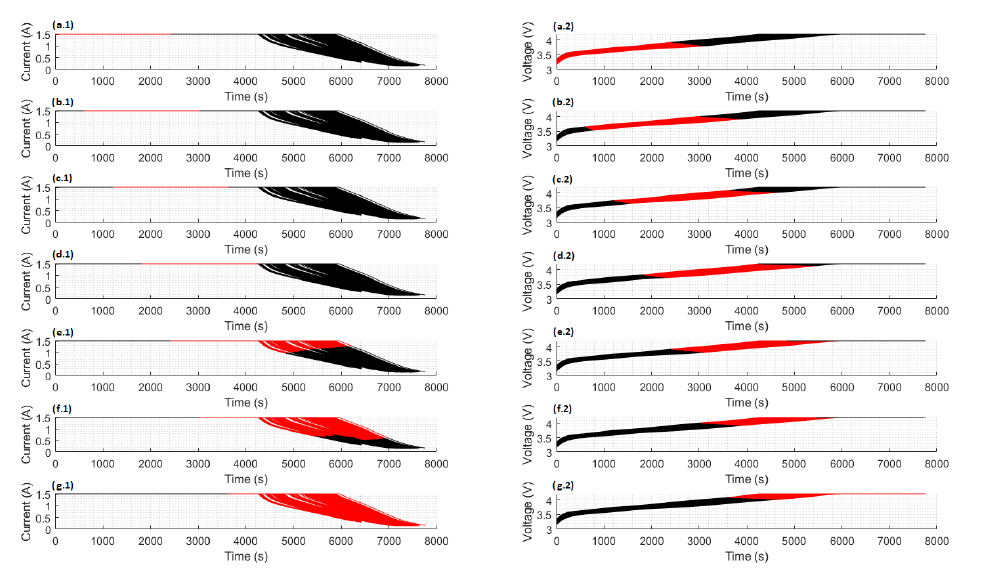
Figure 6. Fixed SOC window equal to 40% moving over the entire domain, for the generation of datasets. ( a.1 , a.2 ) are, respectively, current and voltage of SOC window [0,40]. ( b.1 , b.2 ) are, respectively, current and voltage of SOC window [10,50]. ( c.1 , c.2 ) are, respectively, current and voltage of SOC window [20,60]. ( d.1 , d.2 ) are, respectively, current and voltage of SOC window [30,70]. ( e.1 , e.2 ) are, respectively, current and voltage of SOC window [40,80]. ( f.1 , f.2 ) are, respectively, current and voltage of the SOC window [50,90]. ( g.1 , g.2 ) are, respectively, current and voltage of SOC window [60,100]. In the graph, curves for the entire cycles are plotted in